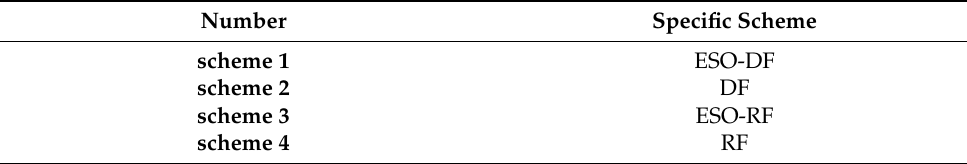
Table 2. The scheme of actuator fault diagnosis and fault localization.